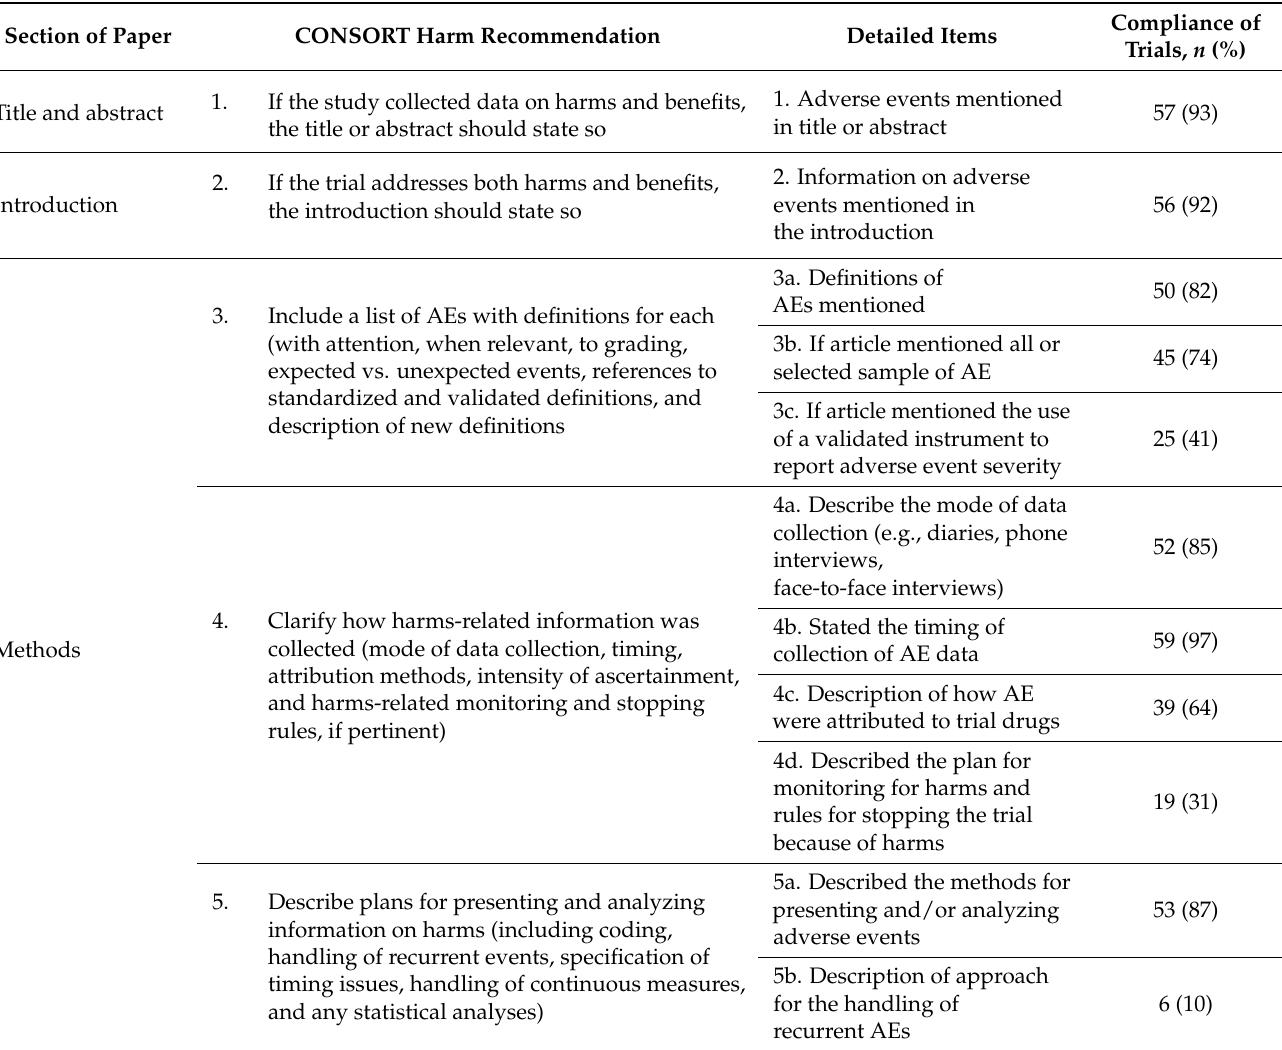
Table 2. Items fulfilled against the quality of reporting criteria (Consolidated Standards of Reporting Trials (CONSORT) Extension for Harm) ( n =